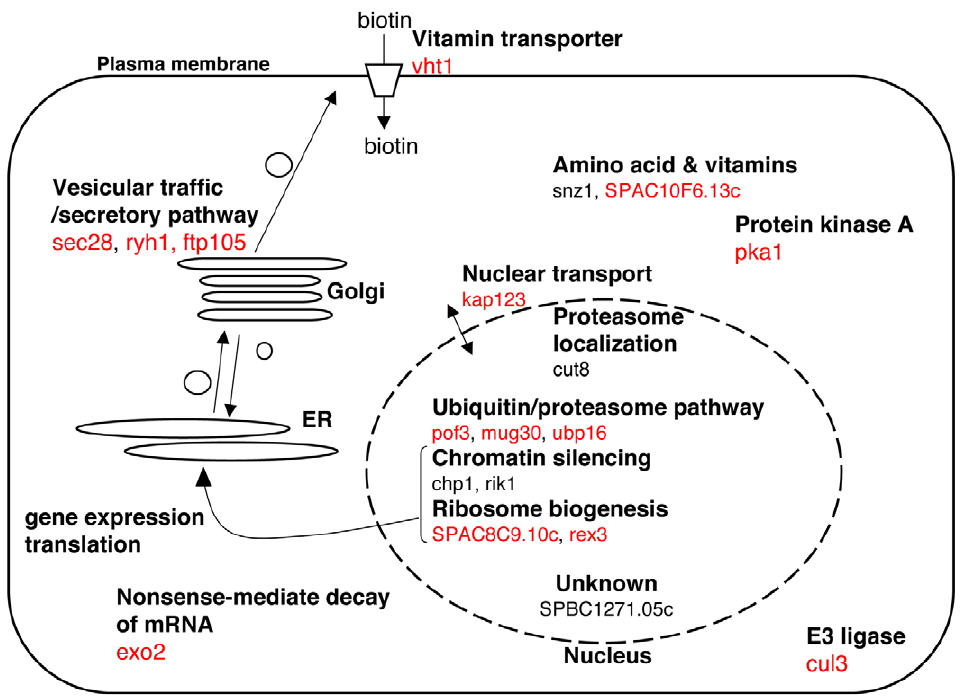
Figure 3. Summary of identified SLB genes. Thirteen conserved SLB genes are shown in red.